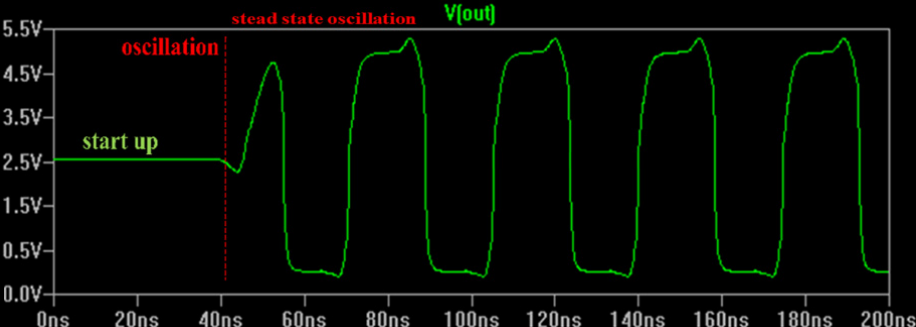
Figure 8. Simulation result under the oscillation condition for Colpitts oscillator.